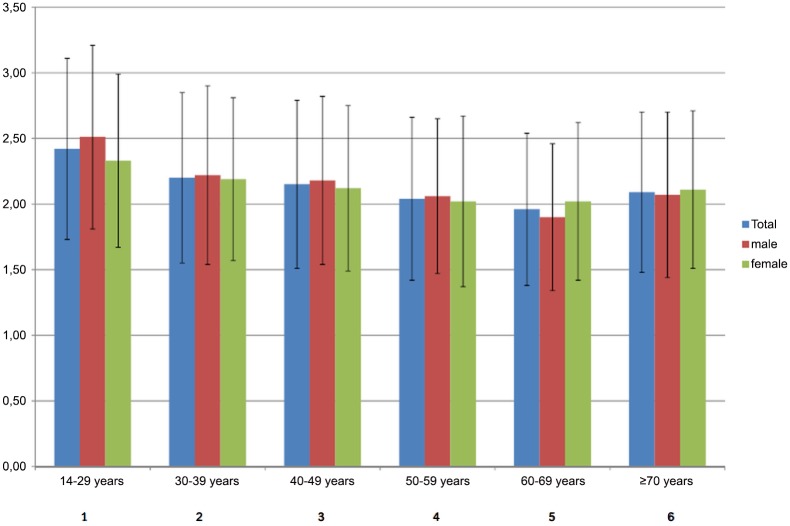
Procrastination scores across the life span according to sex.Note: Post hoc analyses were performed using the Scheffe’-Tests revealing 1>2–6; 2>4,5; 3>5. Age group 14–29 yrs.: Ntotal = 423; Nmale = 208; Nfemale = 215; 30–39 yrs.: Ntotal = 339; Nmale = 153; Nfemale = 186; 40–49 yrs.: Ntotal = 462; Nmale = 213; Nfemale = 249; 50–59 yrs.: Ntotal = 501; Nmale = 229; Nfemale = 272; 60–69 yrs.: Ntotal = 420; Nmale = 211; Nfemale = 209; ≥ 70 yrs.: Ntotal = 371; Nmale = 157; Nfemale = 214.